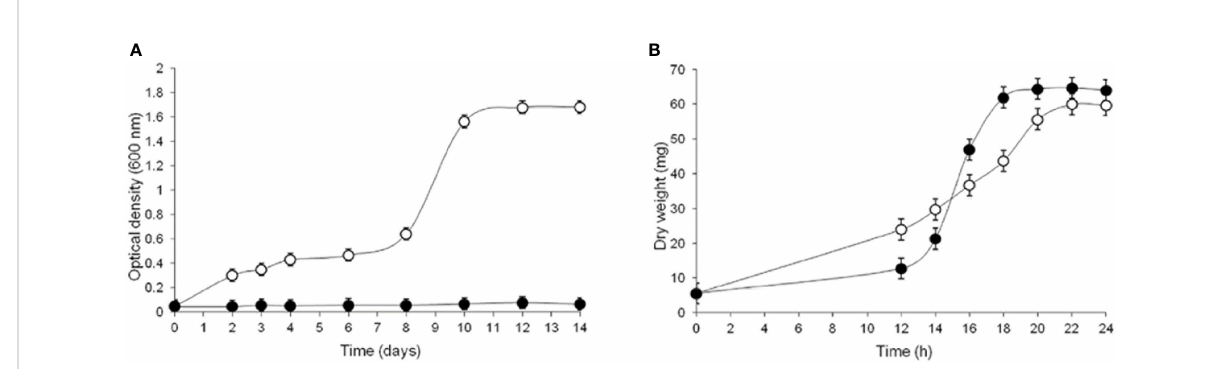
FIGURE 3 In fl uence of CR on growth of both morphotypes of S. schenckii . CN were inoculated and allowed to propagate in YPG medium in conditions set to produce yeast (A) or mycelial (B) cells in the absence (open circles) and presence (closed circles) of 15 m M (A) and 150 m M (B) CR and growth was evaluated after the indicated times. Reproduced from Sa ́ nchez-Lo ́ pez et al., 2019, with permission from Springer Nature, License Number 501734282 (May 24,